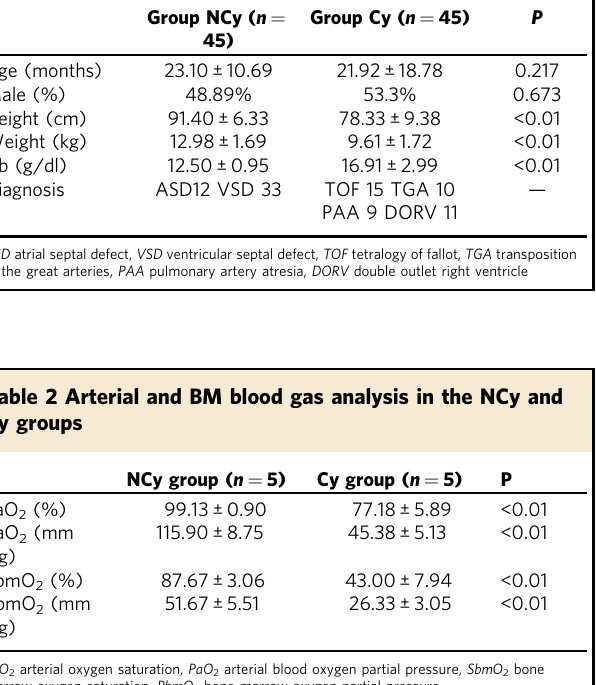
Table 1 Baseline characteristics of the enrolled patients